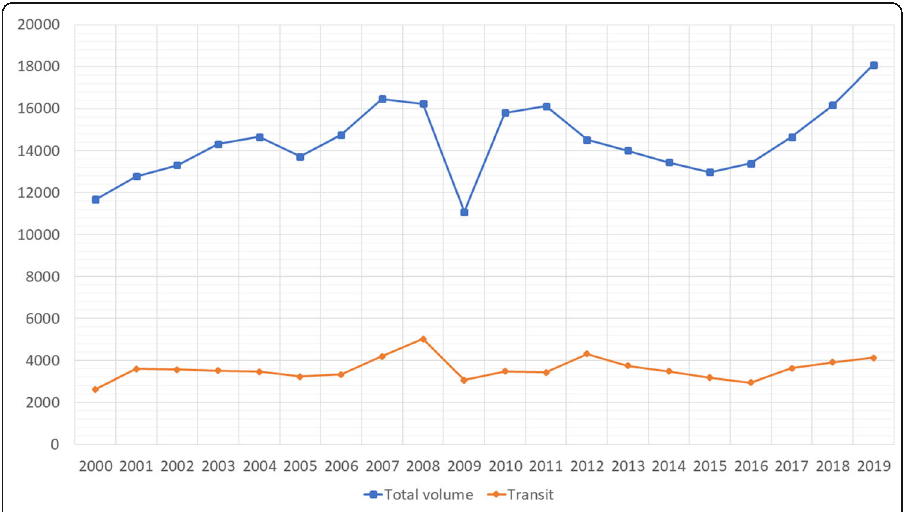
Fig. 2 Total and transit throughput at HaminaKotka 2000 – 2019 (thousand tons; Port of HaminaKotka